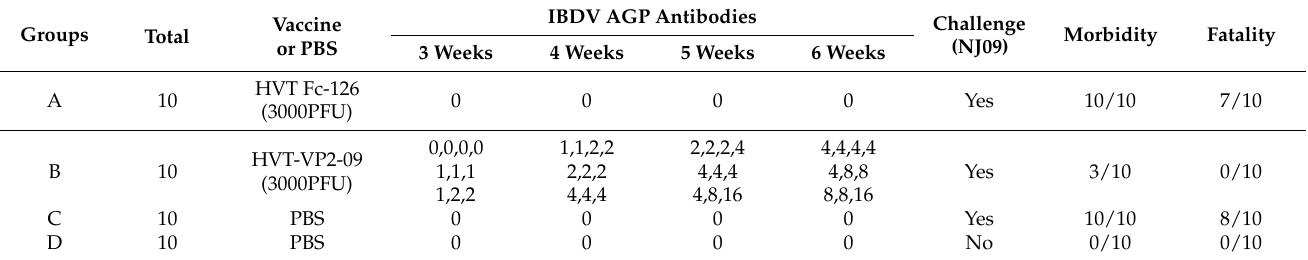
Table 2. Groups of animals tested to evaluate the efficacy and immunogenicity of